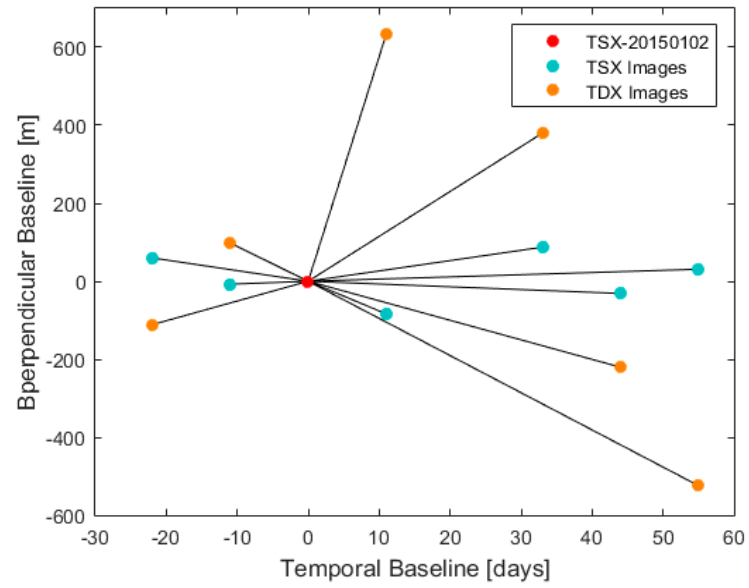
Figure 2. Interferometric formation of the proposed method for deformation estimation.